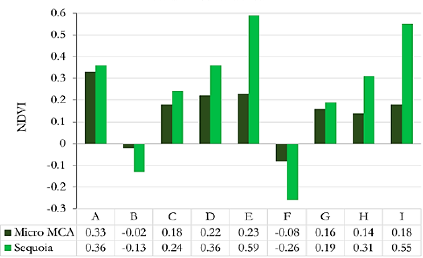
Figure 15. Zonal NDVI average for Micro MCA and Sequoia